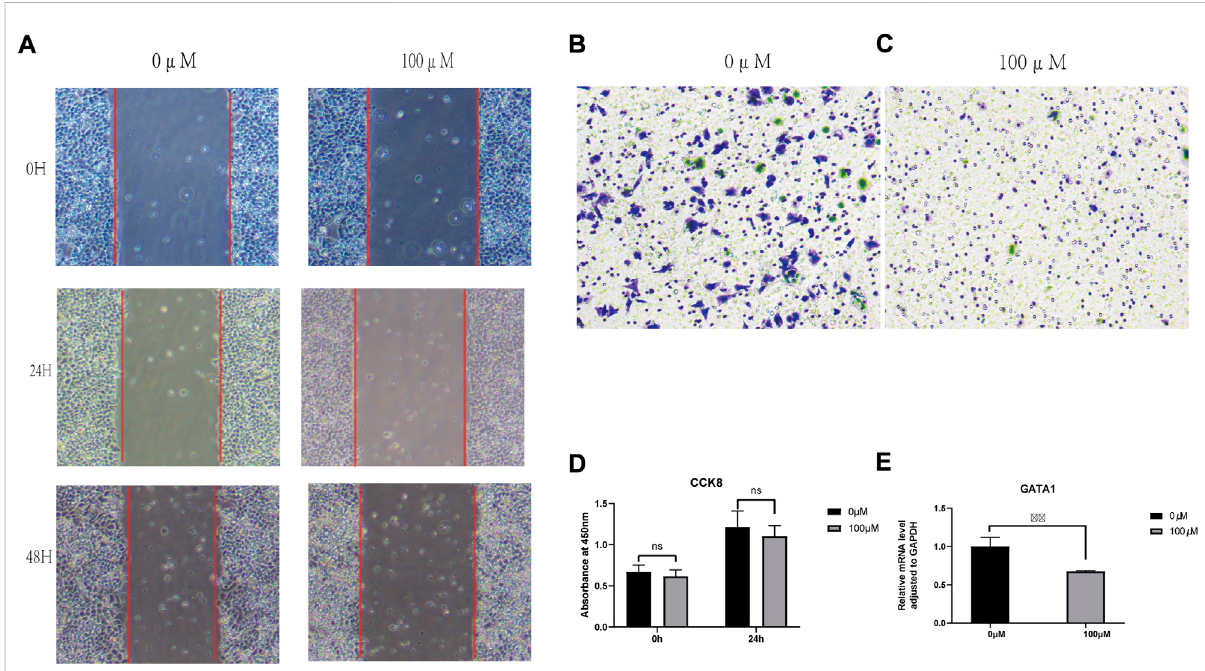
FIGURE 10 Experimental veri fi cation. (A) Wound Healing Assay; (B,C) Transwell assay; (D) CCk8 cytotoxicity test; (E)